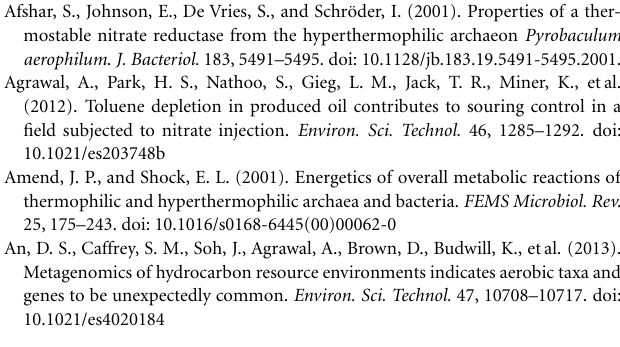
(B) , unstable displacement due to thief zones (C) and unstable displacement through fractures (especially for carbonates; D ). Oil phase is indicated in black, water in blue. Small black blobs indicated residual oil after being flooded, small blue blobs indicate connate water before being